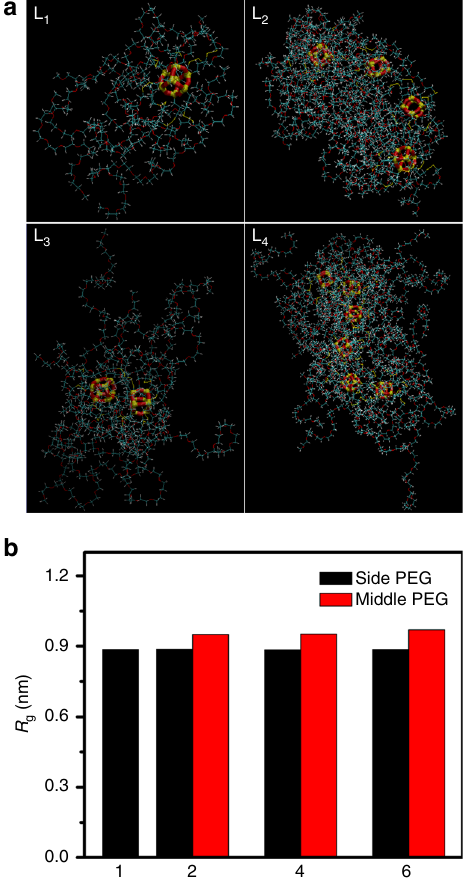
Fig. 4 MD studies of the micellar axial growth mechanism. a The typical conformation of POSS m -PEG n oligomer in water with various chain lengths at (L 1 ) 1, (L 2 ) 2, (L 3 ) 4, and (L 4 ) 6. Water molecule is not shown for clarity. The inner cube represents the POSS core, wherein the yellow cylinder represents the silicon (Si) atom and the red cylinder represents the oxygen (O) atom. The outer linkage represents the PEG shell, wherein the red cylinder represents the oxygen (O) atom, the yellow cylinder represents the sulfur (S) atom, the wathet blue cylinder represents the carbon (C) atom, and the white cylinder represents the hydrogen (H) atom. b The average Rg for PEG chain on the side and middle of POSS molecules (see Supplementary Table 1 for the detailed simulation